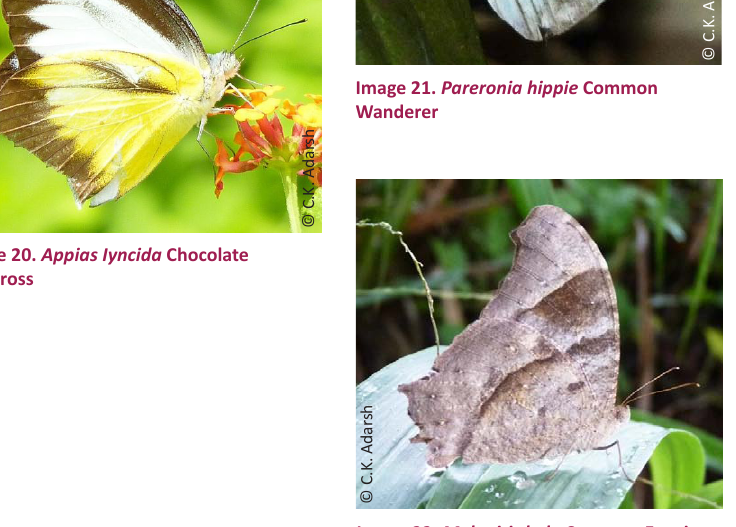
Image 22. Melanitis leda Common Evening